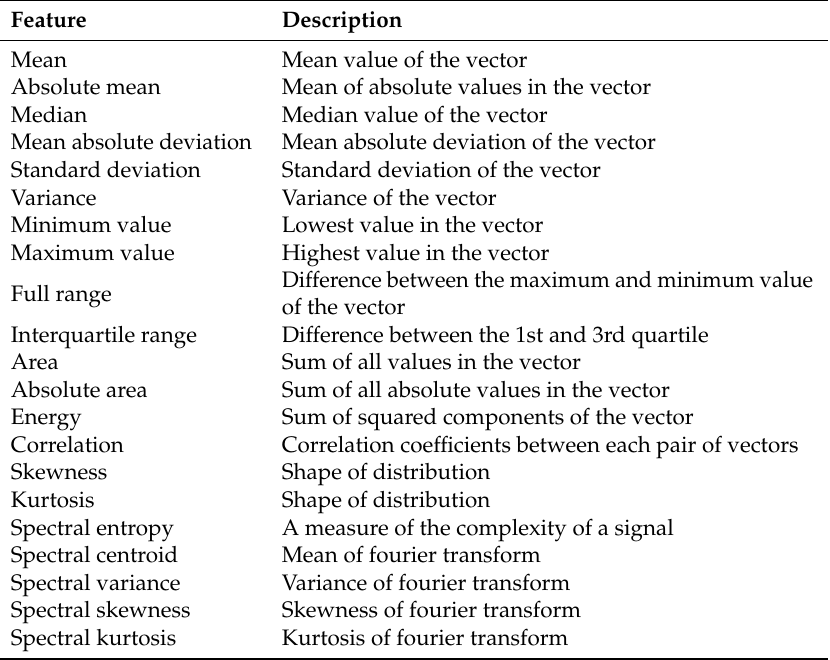
Table 2. The features extracted from each acceleration segment. Each feature was extracted from four signals; the x -, y -, z -acceleration and the acceleration